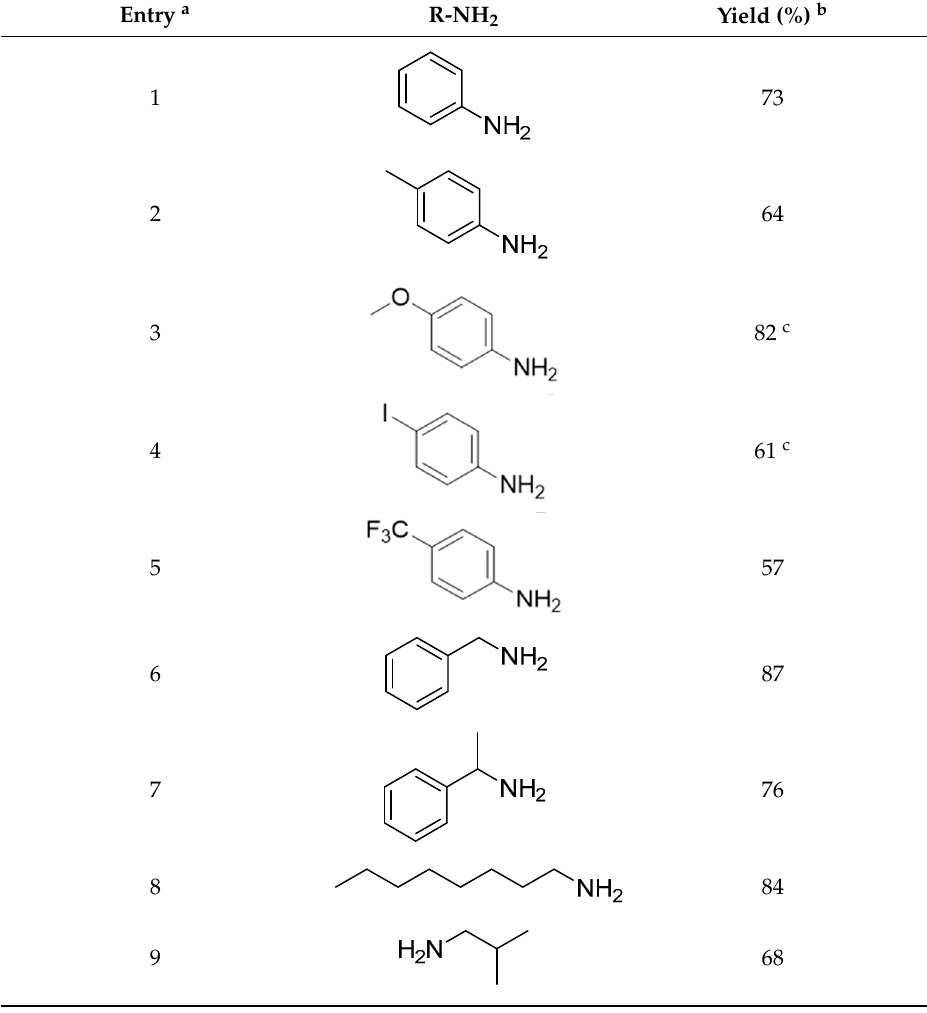
Table 2. PdCu / C β CAT catalyzed the reductive amination of di ff erent amines with benzaldehyde. Table 2. PdCu/C β CAT catalyzed the reductive amination of different amines with benzaldehyde. Table 2. PdCu/C β CAT catalyzed the reductive amination of different amines with benzaldehyde. Table 2. PdCu/C β CAT catalyzed the reductive amination of different amines with benzaldehyde. Table 2. PdCu/C β CAT catalyzed the reductive amination of different amines with benzaldehyde. Table 2. PdCu/C β CAT catalyzed the reductive amination of different amines with benzaldehyde. Table 2. PdCu/C β CAT catalyzed the reductive amination of different amines with benzaldehyde. Table 2. PdCu/C β CAT catalyzed the reductive amination of different amines with benzaldehyde. Table 2. PdCu/C β CAT catalyzed the reductive amination of different amines with benzaldehyde. Table 2. PdCu/C β CAT catalyzed the reductive amination of different amines with benzaldehyde. Entry a Entry